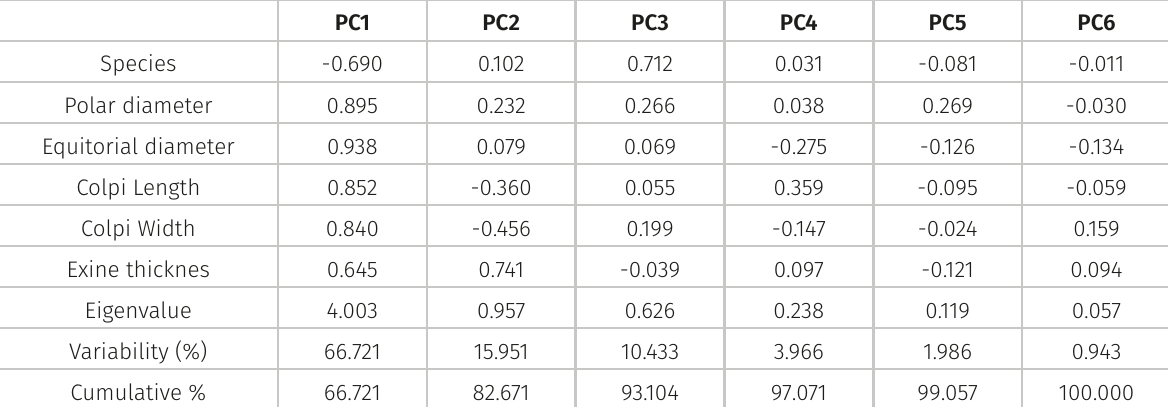
Table V. Correlation coefficients for metric variables of principal component analysis (PCA). Ordination in for Solanaceous species. PC1 PC2 Species -0.690 Polar diameter